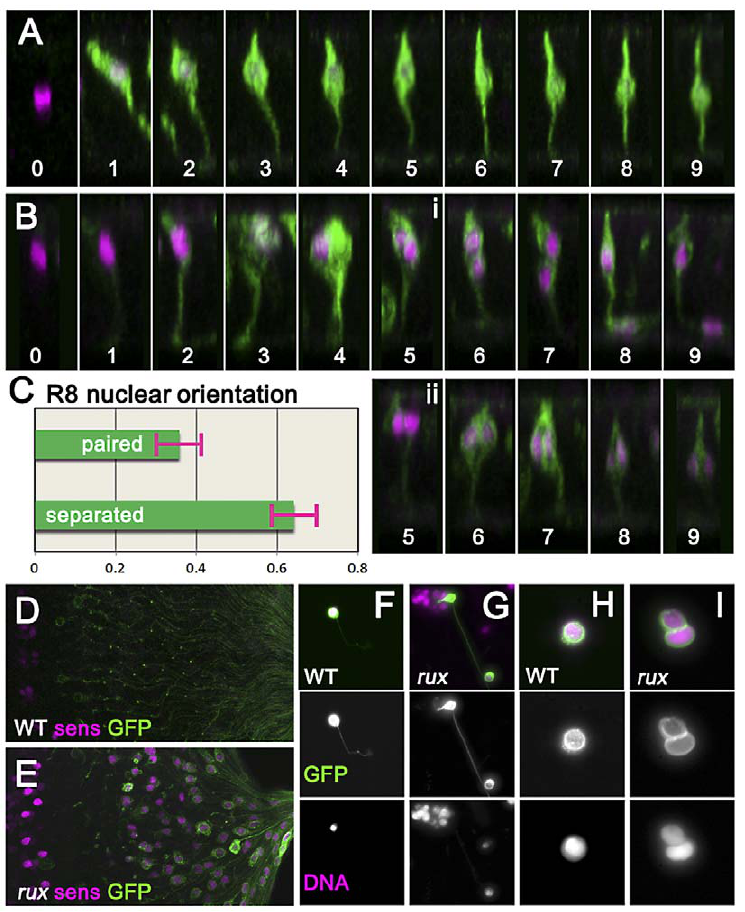
Figure 3. Mitotic R8 cells remain bi-nucleated without completing cytokinesis. (A) Fixed eye discs stained with anti-Sens (magenta). Z-slices of differentiating R8 cells from wild type expressing GFP (green; ommatidial column denoted by numbers). The apical surface is at the top, anterior is to the left. Nuclei rise apically soon after specification, dropping progressively to a somewhat more basal location from column 3 onwards. (B) Z projections of differentiating R8 cells from rux . 109-68Gal4 . GFP expression is often weaker in rux . Around column 3–4, many R8 nuclei are mitotic. Posterior to column 6, most R8 cells retain one nucleus in a normal location while the second drops basally and into the developing axon (i), but in some R8 cells both nuclei remain together in the cell body (ii). (C) quantification of nuclear behavior. (D) the basal third of wild type discs lack R8 nuclei (magenta) near the axons (green). (E) In rux , R8 nuclei accumulate in the basal axons. (F) Trypsin treated, dissociated, R8 cells exclusively exhibit a single nucleus as labeled for DNA (magenta). (G) In partially dissociated rux mutants, R8 cells containing a second nucleus in the axon can be seen. The figure shows an R8 cell whose cell body remains within an ommatidial cluster dissociated from the rest of the eye disc. (H). After extensive dissociation, wt R8 cells become round without axons. (I) 35% of rux 35% cells appear binucleated. See also Video